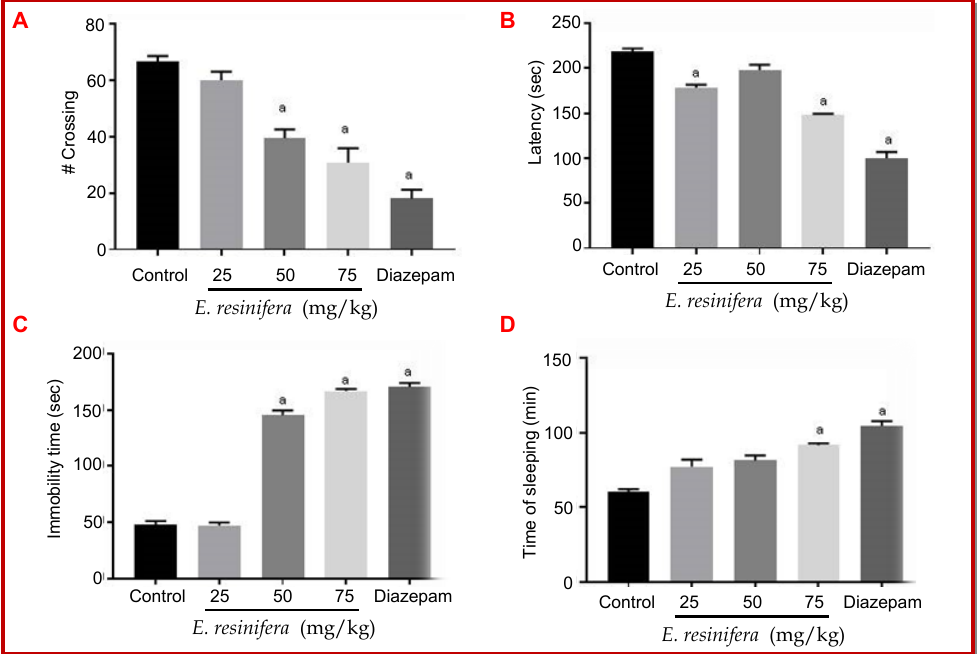
Figure 3: Aqueous latex extract of E. resinifera effect and diazepam (2 mg/kg) in open field test (A, C) and thiopental-induced sleeping test (B, D) in mice (n=6/group). Data are given as mean ± SEM, where superscript ‘a’ indicates p<0.05, statistically signifi- cant difference between the groups. One- way ANOVA followed by Tukey’s post hoc